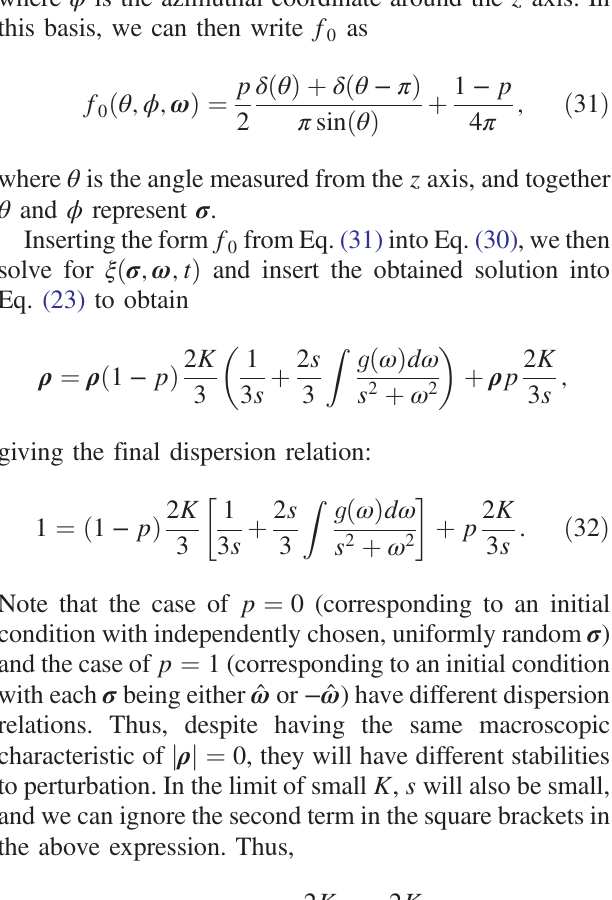
σ · ˆ ω have been plotted at T ¼ 0 i ¼ i i as a function of time for 50 randomly chosen i